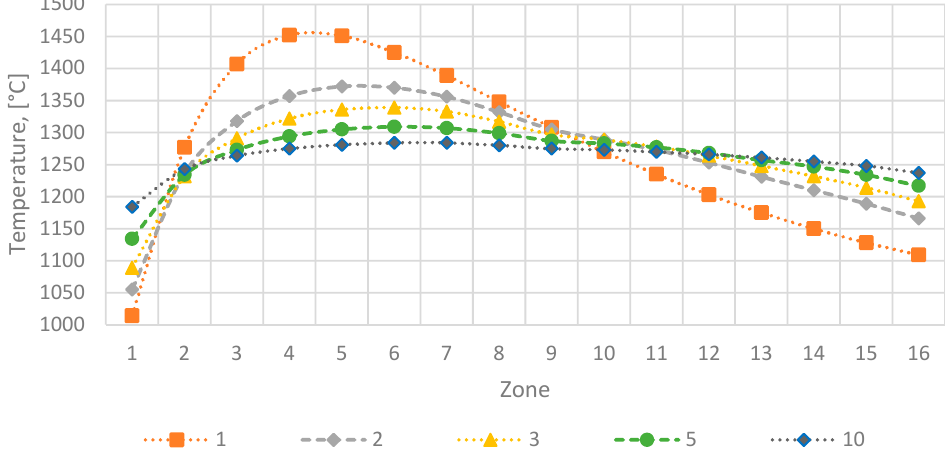
Figure 8. Temperature distribution over the zones of the furnace with variable rate of recirculation of furnace gases with maximum heat output and minimum resulting heat flux to metal.